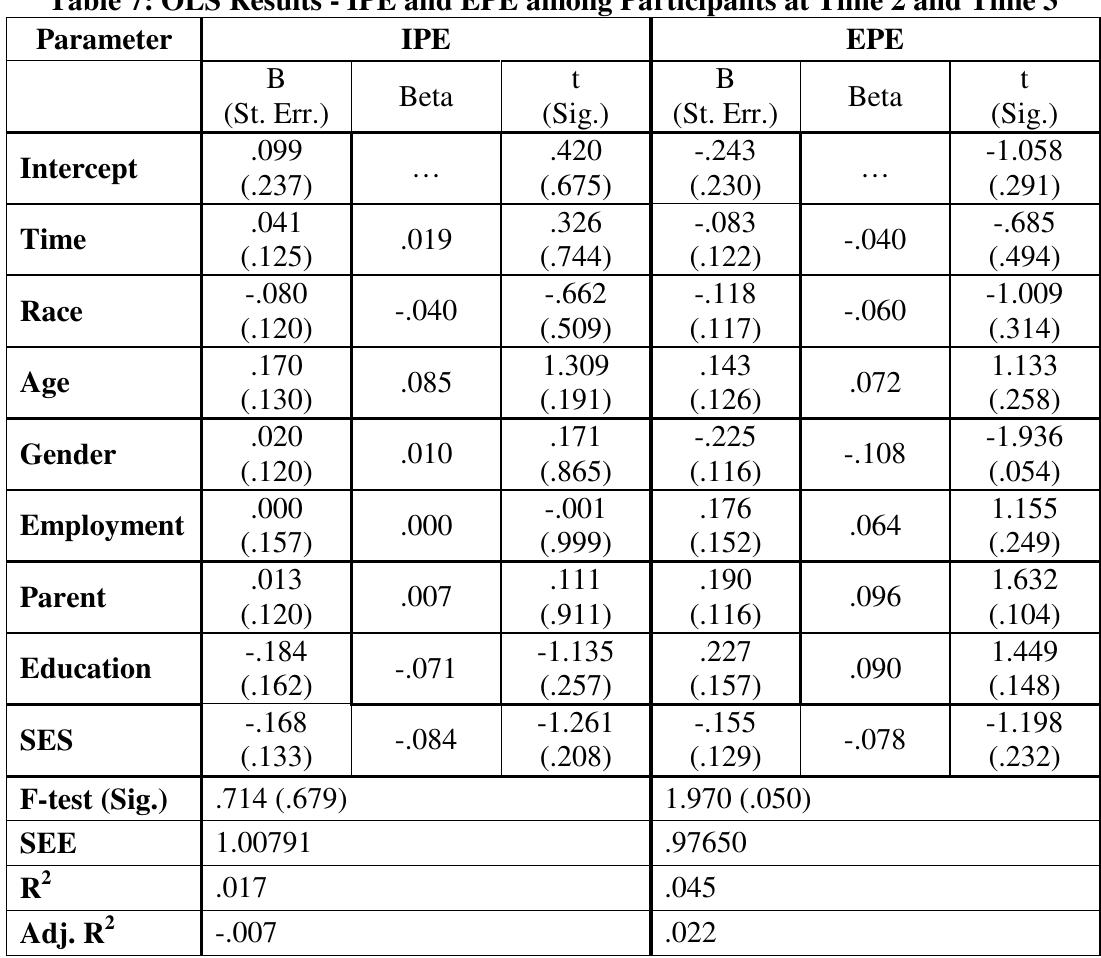
Table 7: OLS Results - IPE and EPE among Participants at Time 2 and Time 3